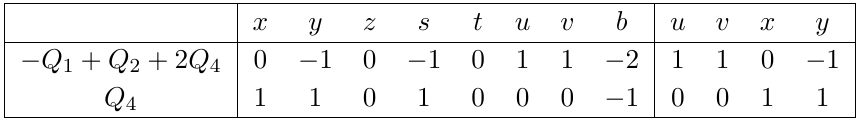
Table 5 . ( C (cid:3) ) actions on exceptional locus b =